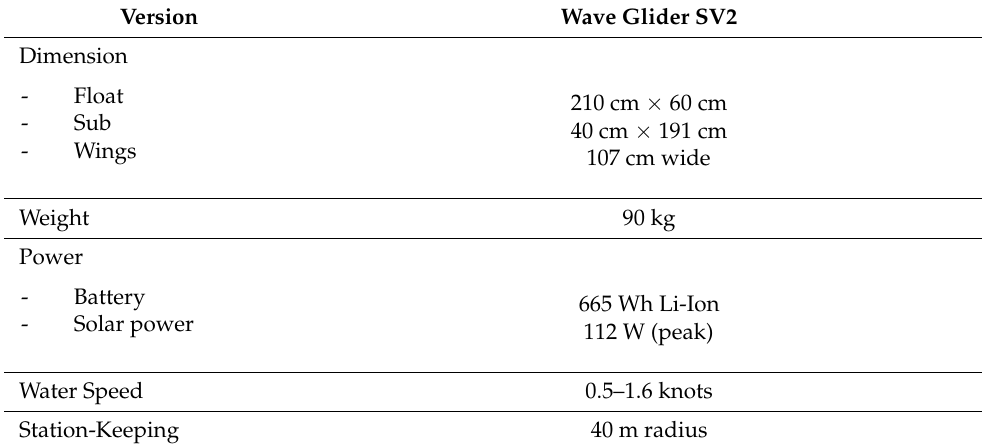
Table 1. The wave glider